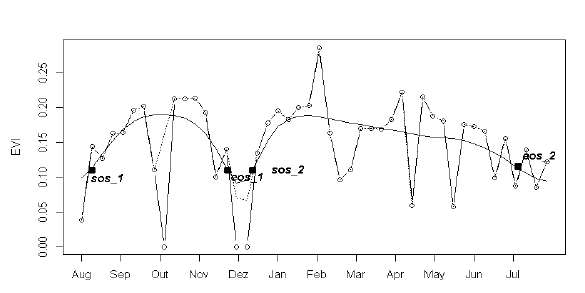
Figure 6. Time series EVI spectral profile for a perennial crop sample of rubber trees.